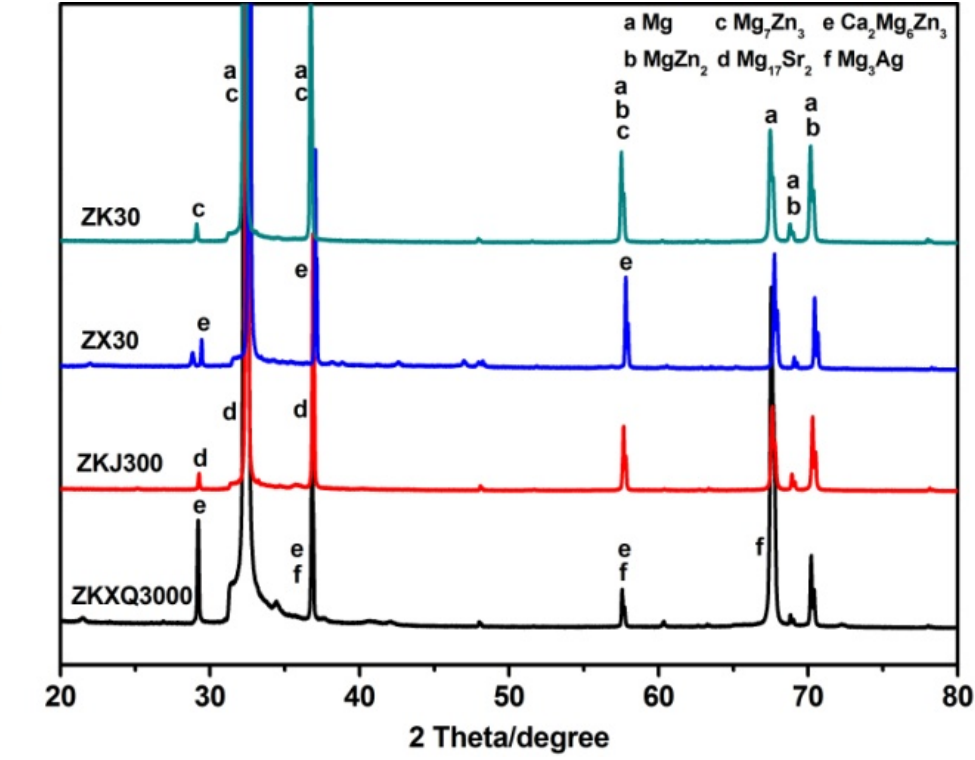
Figure 2. The XRD patterns of as ‐ extruded ZX30, ZK30, ZKJ300 and ZKXQ3000 alloys.